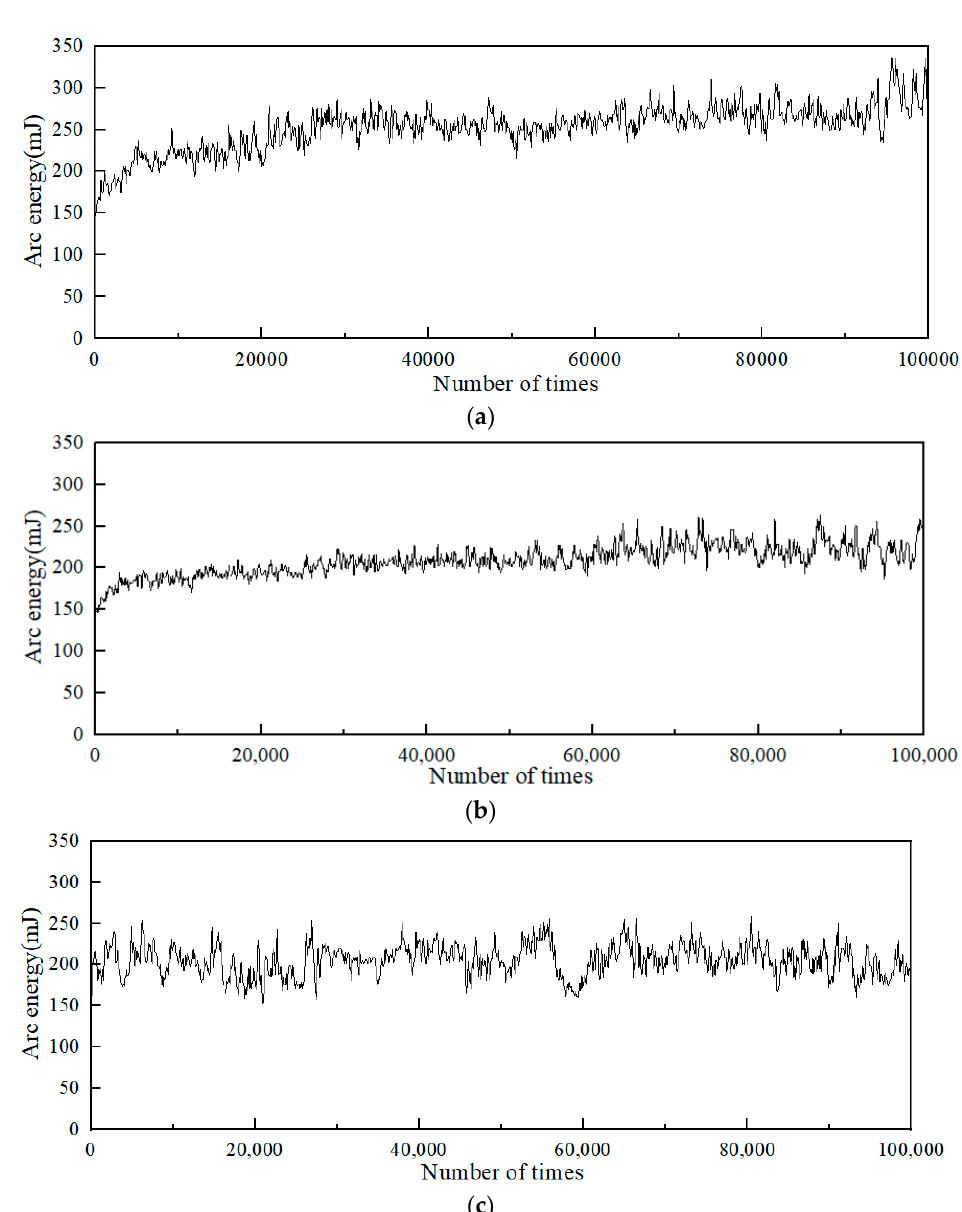
Figure 4. Arc energy: ( a ) Ag/Ni, ( b ) Ag/Ni-Cu, and ( c ) Ag/Ni-C.